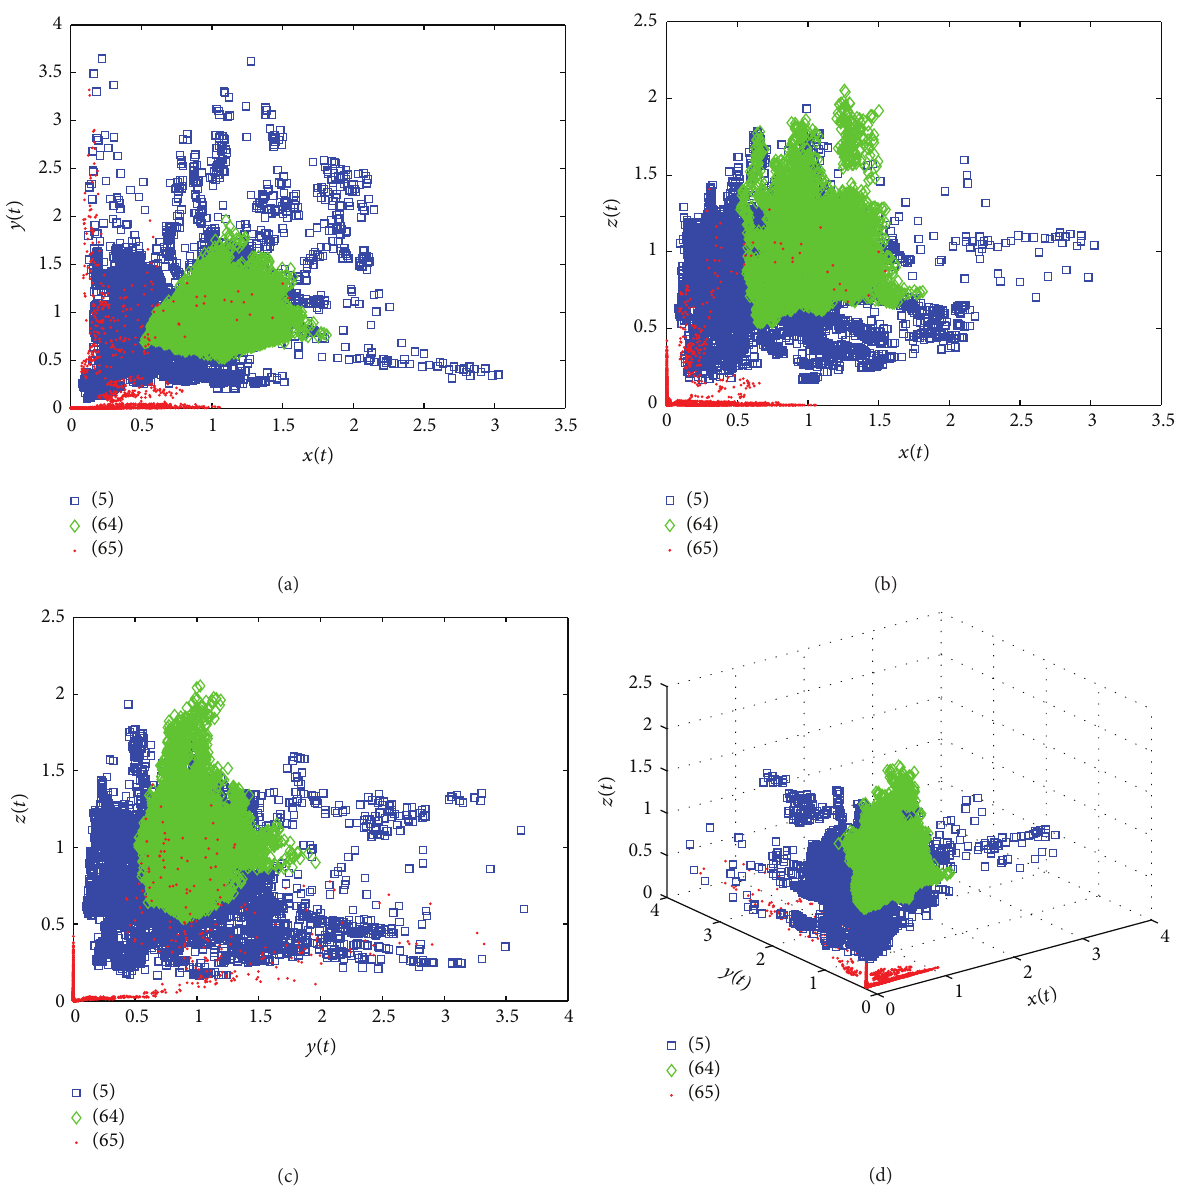
Figure 5: The subgraphs (a), (b), (c), and (d) denote the discrete point distribution of two subsystems and the overall system in 𝑥𝑦 , 𝑥𝑧 , 𝑦𝑧 , and 𝑥𝑦𝑧 , respectively. The blue, green, and red areas represent the overall system (5), subsystem (64), and subsystem (65), respectively. The green area which means stochastic permanence is far away from the origin while most points of the red area which means extinction lie in the origin. Under the control of Markov chain, the blue area also keeps away from the origin and means stochastic permanence in Case 1 of Example